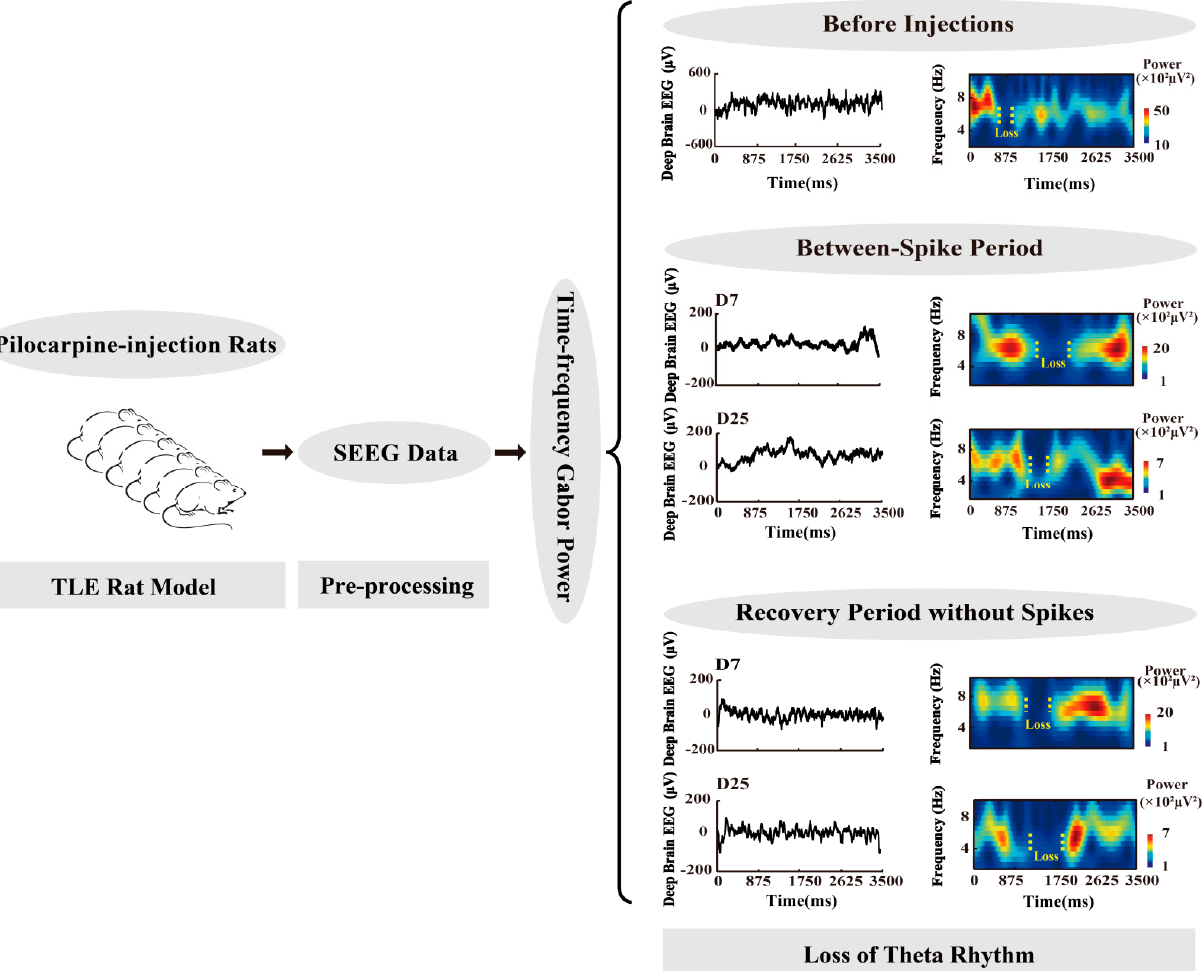
Figure 1. Methodology flowchart for this